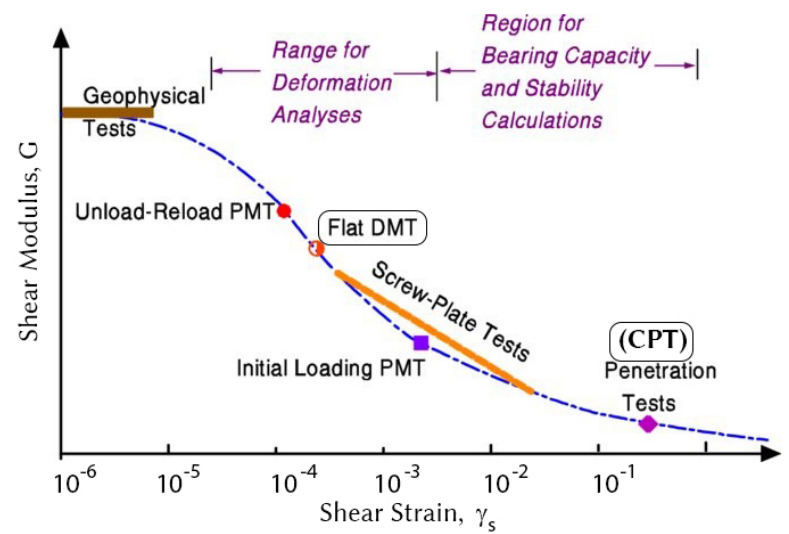
Figure 2. Shear strain for different in- situ probes, Mayne et al.,